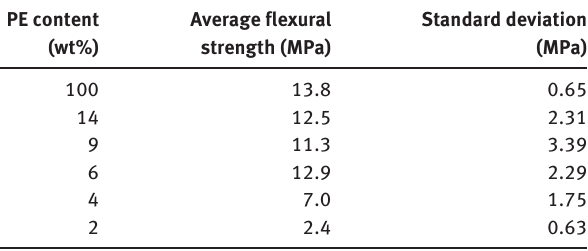
Table 2 Testing results of Group B IOH